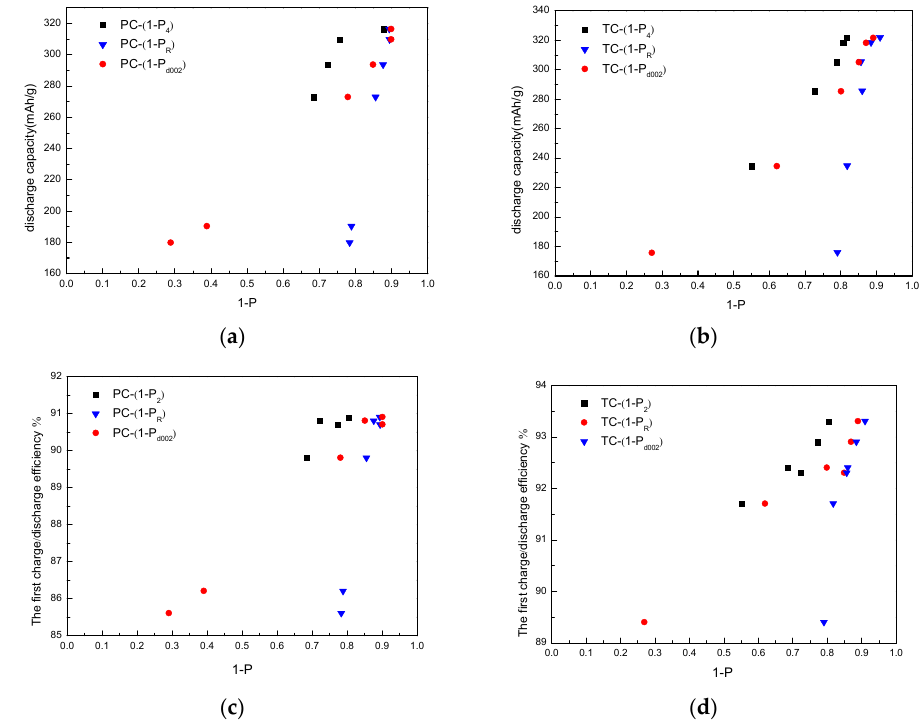
Figure 7. The relationships between graphitization degree and electrochemical properties of petroleum coke and pitch coke. ( a ) Plots of graphitization degree versus the discharge capacity for petroleum coke; ( b ) Plots of graphitization degree versus the discharge capacity for pitch coke; ( c ) Plots of graphitization degree versus the first charge/discharge efficiency for petroleum coke; ( d ) Plots of graphitization degree versus the first charge/discharge efficiency for pitch coke. Table 5. The degree of disorder and lithium performance of petroleum coke and pitch coke at different heat treatment temperatures.